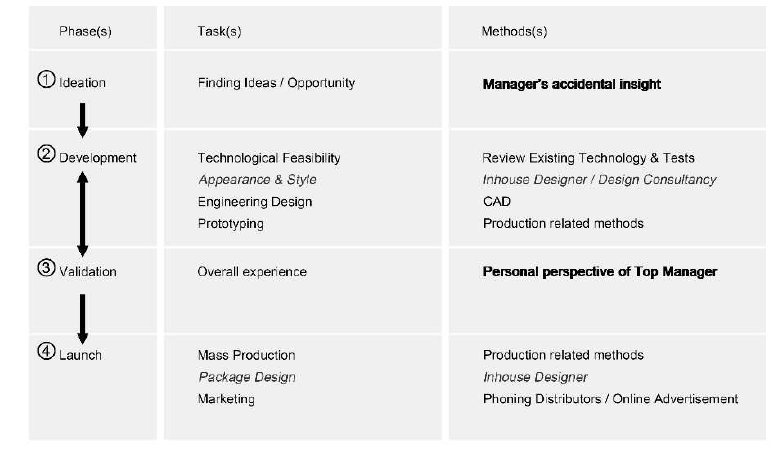
Figure 2: Current NPD Process Model in Selected